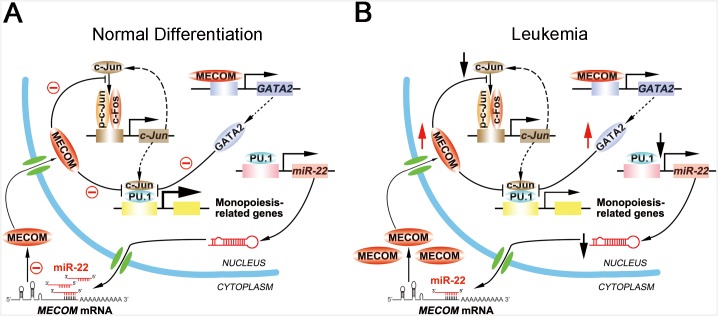
The molecular models of miR-22’s involvement in monocyte/macrophage differentiation regulation and AML development.A. During normal monocytic/macrophagic differentiation, the increase of PU.1 expression resulted in up-regulation of miR-22 levels and consequent down-regulation of MECOM expression. The decrease of MECOM prevented its inhibition of the phosphorylation of c-Jun. The increased p-c-Jun then promoted c-Jun expression and thus reinforced the cooperation between c-Jun and PU.1, which plays an important role in the differentiation. The decrease of MECOM and the consequent reduction of GATA-2 also contributed to the cooperation between c-Jun and PU.1 by releasing their inhibition on the cooperation. B. Abnormal decrease of PU.1 expression resulted in a decrease of miR-22 levels and consequent increase of MECOM levels. The abnormally increased MECOM reduced interaction between c-Jun and PU.1 by decreasing c-Jun levels and increasing MECOM- and GATA2-mediated interference in the interaction, which led to the differentiation blockage and development of leukemia.